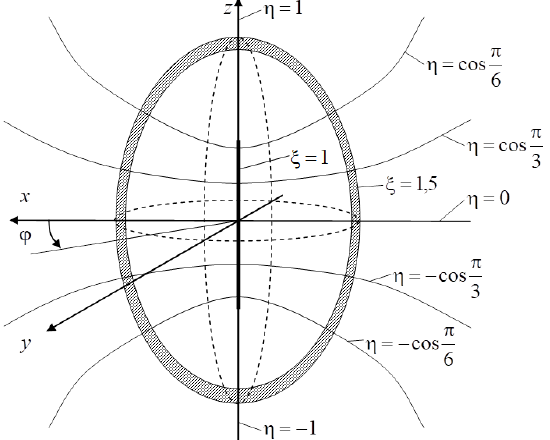
Fig. 1. Prolate spheroidal